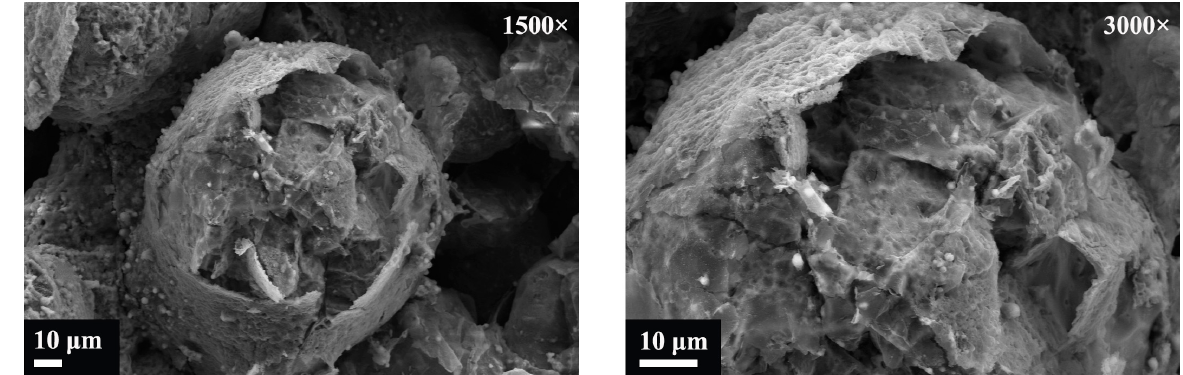
Figure 14. SEM photographs of combustion residues of a single Al-Li alloy microparticle.